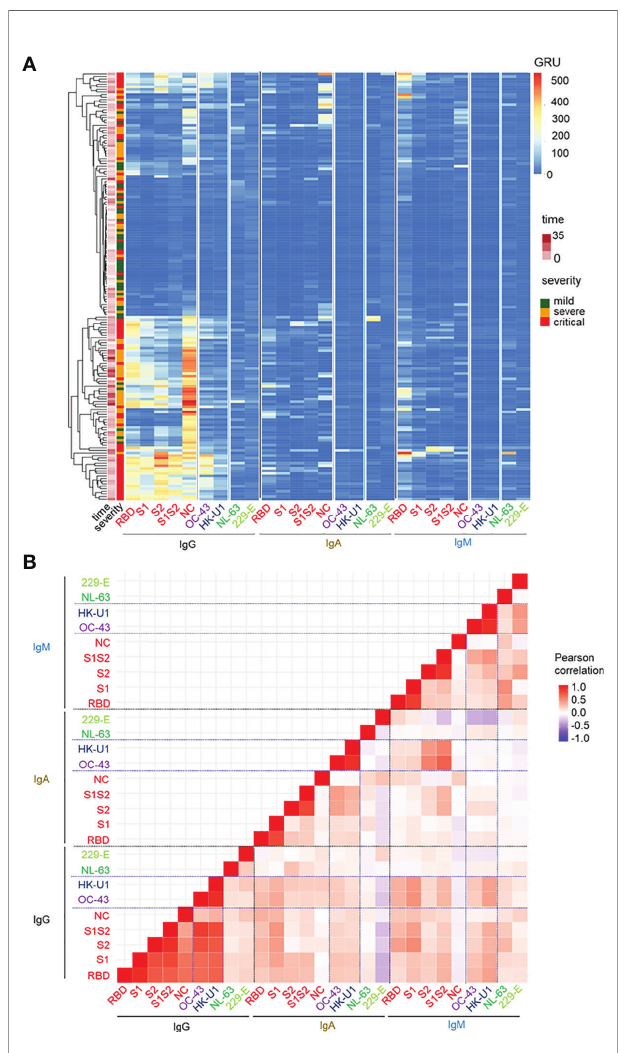
FIGURE 2 | Beta-HCoV-primed individuals mount IgG-dominated anti- SARS-CoV-2 responses. (A) Heatmap representation of the IgG, IgA, IgM anti-SARS-CoV-2 virus components (S1, S1S2, RBD, NC) titres (columns) for the entire cohort of patients (rows). Patients were labelled according to their corresponding severity state (moderate, severe, critical) and time point of antibody measurement. (B) Pairwise correlation heatmap of the corresponding IgM, IgG and IgA titres in all COVID-19 patients. The Pearson correlation coef fi cient is colour-coded. The vertical lines separate SARS-CoV- 2 and anti-alpha and beta-HCoV Ig-related